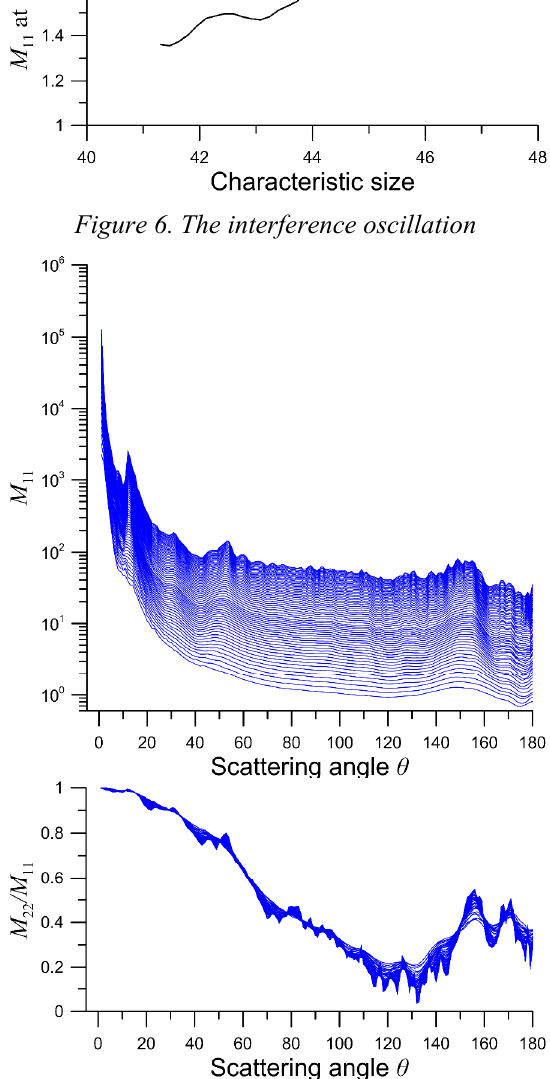
Figure 7. The elements of the Mueller matrix for a dust particle with size from 40 to 220.